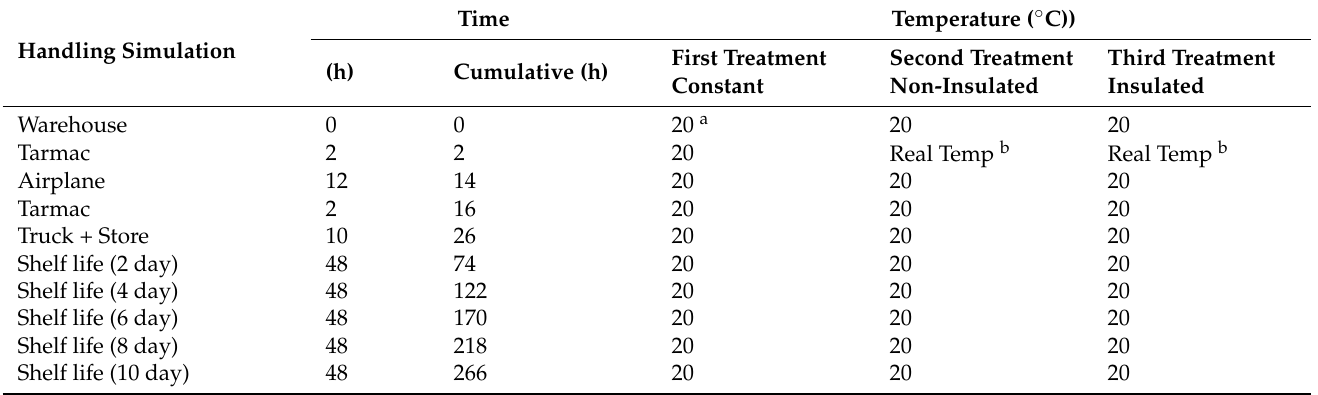
Table 1. Time and temperature used for ‘Nam Dok Mai Si Thong’ mangoes during simulation of handling from the tarmac to the customer under constant, non-insulated, and insulated